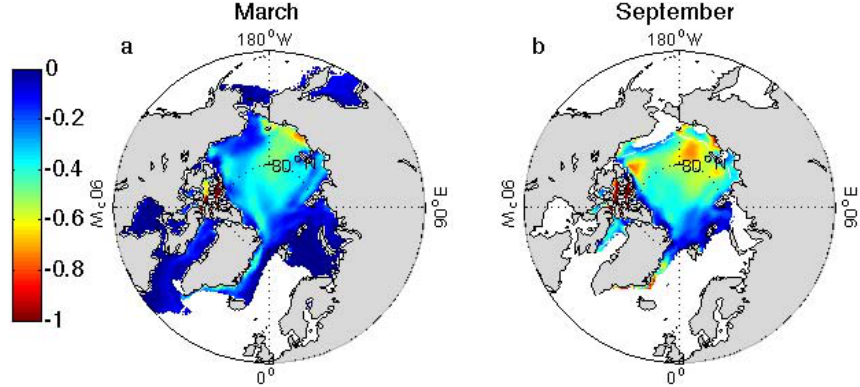
Fig. 15. March and September sea ice thickness change (in meters) due to light-absorbing particles (BC and dust) in terrestrial snow only.